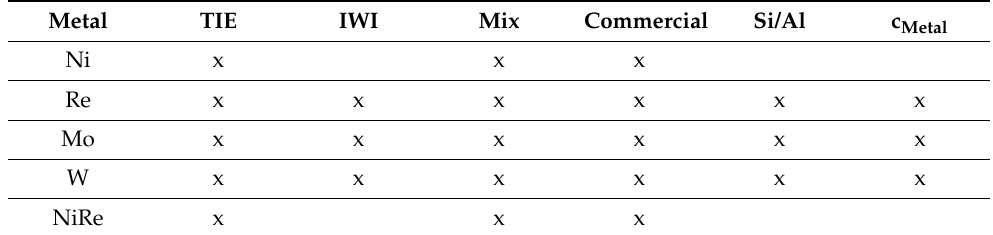
Table A1. Entity of prepared metathesis catalysts for highest propene selectivity and the correspond- ing temperature, conversions and product